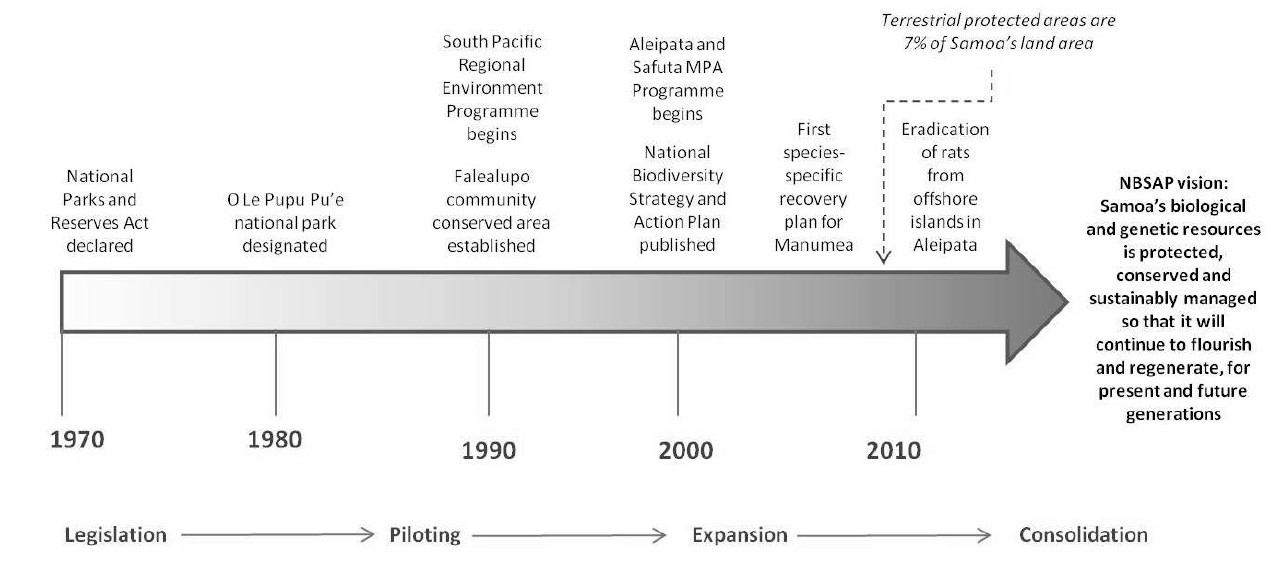
Fig. 2. Time line of key events in history of terrestrial-based conservation in